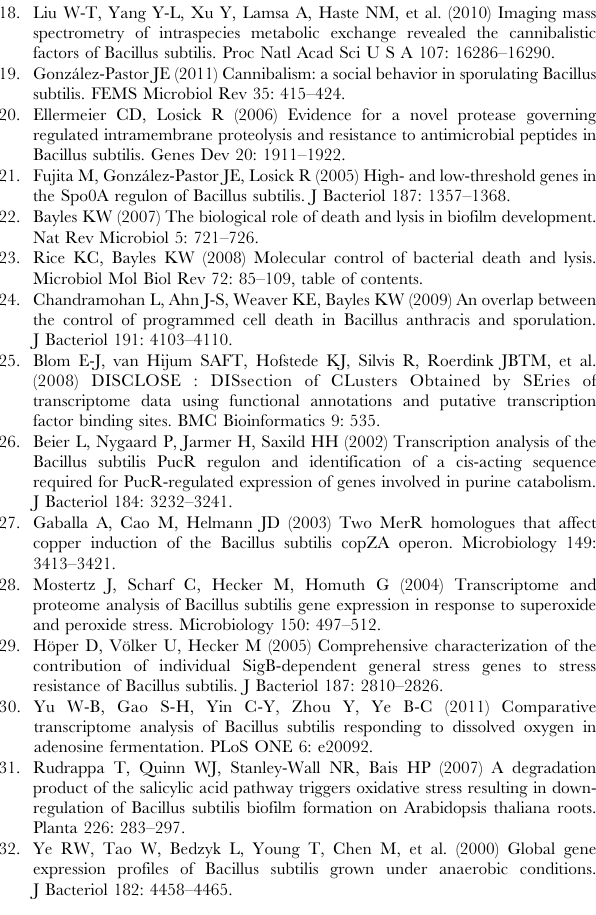
Figure S2 Significantly overrepresented category containing phage related genes (log transformed p-values (a´ = 0.05 and Bonferroni corrected)) scaled per time point. This category was found significantly overrepresented for timepoints 16–19. Figure S3 Expression graph of yknWXYZ and yfhLM which mediate SigW dependent resistance to SdpC . Figure S4 Overview of identified binding sites that overlapped with known binding sites. The first column displays the averaged expression level of the gene members of a cluster. The second column describes the name of the known regulator of which some known binding sites were identified. E.g.; the first cluster consists of 8 operon members of which 7 members contain the Fur binding site in their upstream regions that was identified by DISCLOSE. The identified motifs are visualized as sequence logos in the third column. Figure S5 Overview of identified binding sites that do not match with known binding sites. The first column displays the averaged expression level of the gene members of a cluster. The second column describes the name of the cluster, the coverage of the motif and the first genes (genes representing putative or known regulators are indicated in bold) of the operons that contain the motif in their upstream region. E.g.; cluster 4 consists of 13 operons of which 3 members contain a putative binding site in